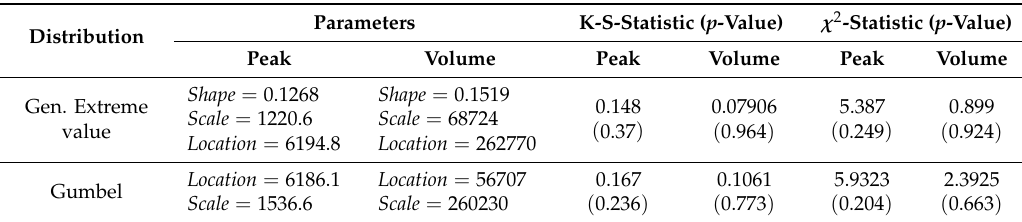
Figure 2. Histogram and marginal distributions for the peak flow and volume of Tarbela dam. Table 4. Marginal distributions parameters and K-S and χ 2 —statistics with p -value for the peak and volume of Tarbela dam